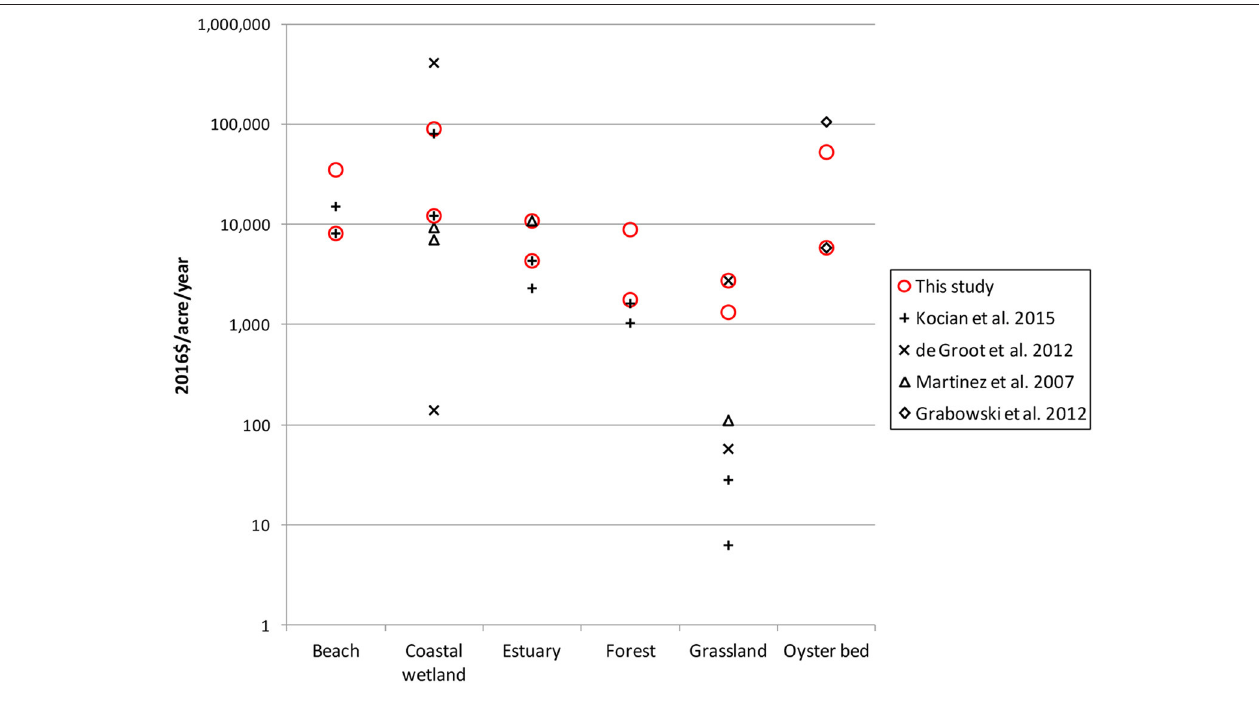
FIGURE 2 | Unit ecosystem service values.